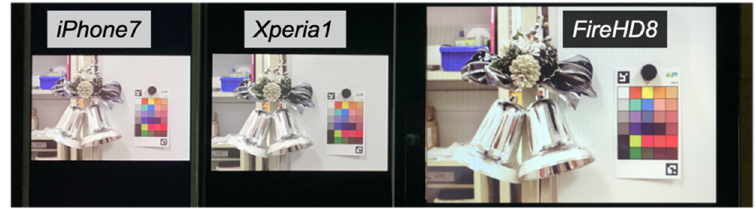
Figure 4. Color matching images. ( a ) iPhone7; ( b ) Xperia1; ( c ) FireHD8.